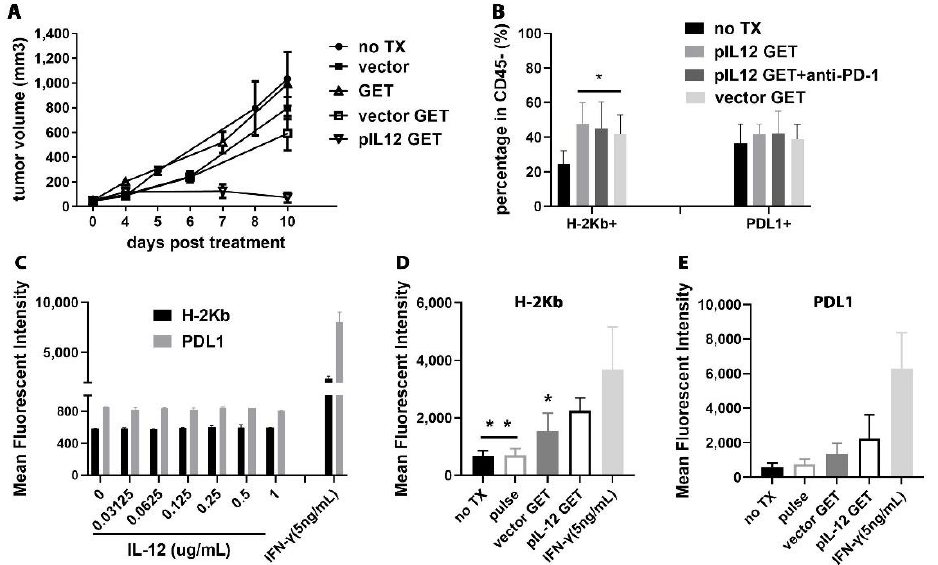
Figure 7. Effect of pIL-12 GET and IFN- γ on H-2Kb and PDL1 expression in B16F10 melanoma. ( A ) Data are presented as tumor (s.c.) growth in each group (n = 5/group). ( B ) Tumor-bearing mice were treated at day 0 with pIL12 GET and anti-PD1. 24 h after treatment, the tumor tissues were isolated, and the single cells were prepared for flow cytometry testing H-2Kb and PDL1 surface expression on B16F10. ( C ). B16F10 cells were seeded into 6-well plate after treatment with electric pulses in the presence of recombination of mouse IL-12 (IFN- γ group as positive control) and grown for 24 h. After that, the expression of H-2Kb and PDL1 were assessed by flow cytometry ( D , E ). Flow cytometry data of H-2Kb and PDL1 surface expression on B16F10 cells in different treatments. After treating with electric pulses, B16F10 cells were seeded into 6-well plate for 24 h culture in 6-well plate. * p < 0.05, ** p <